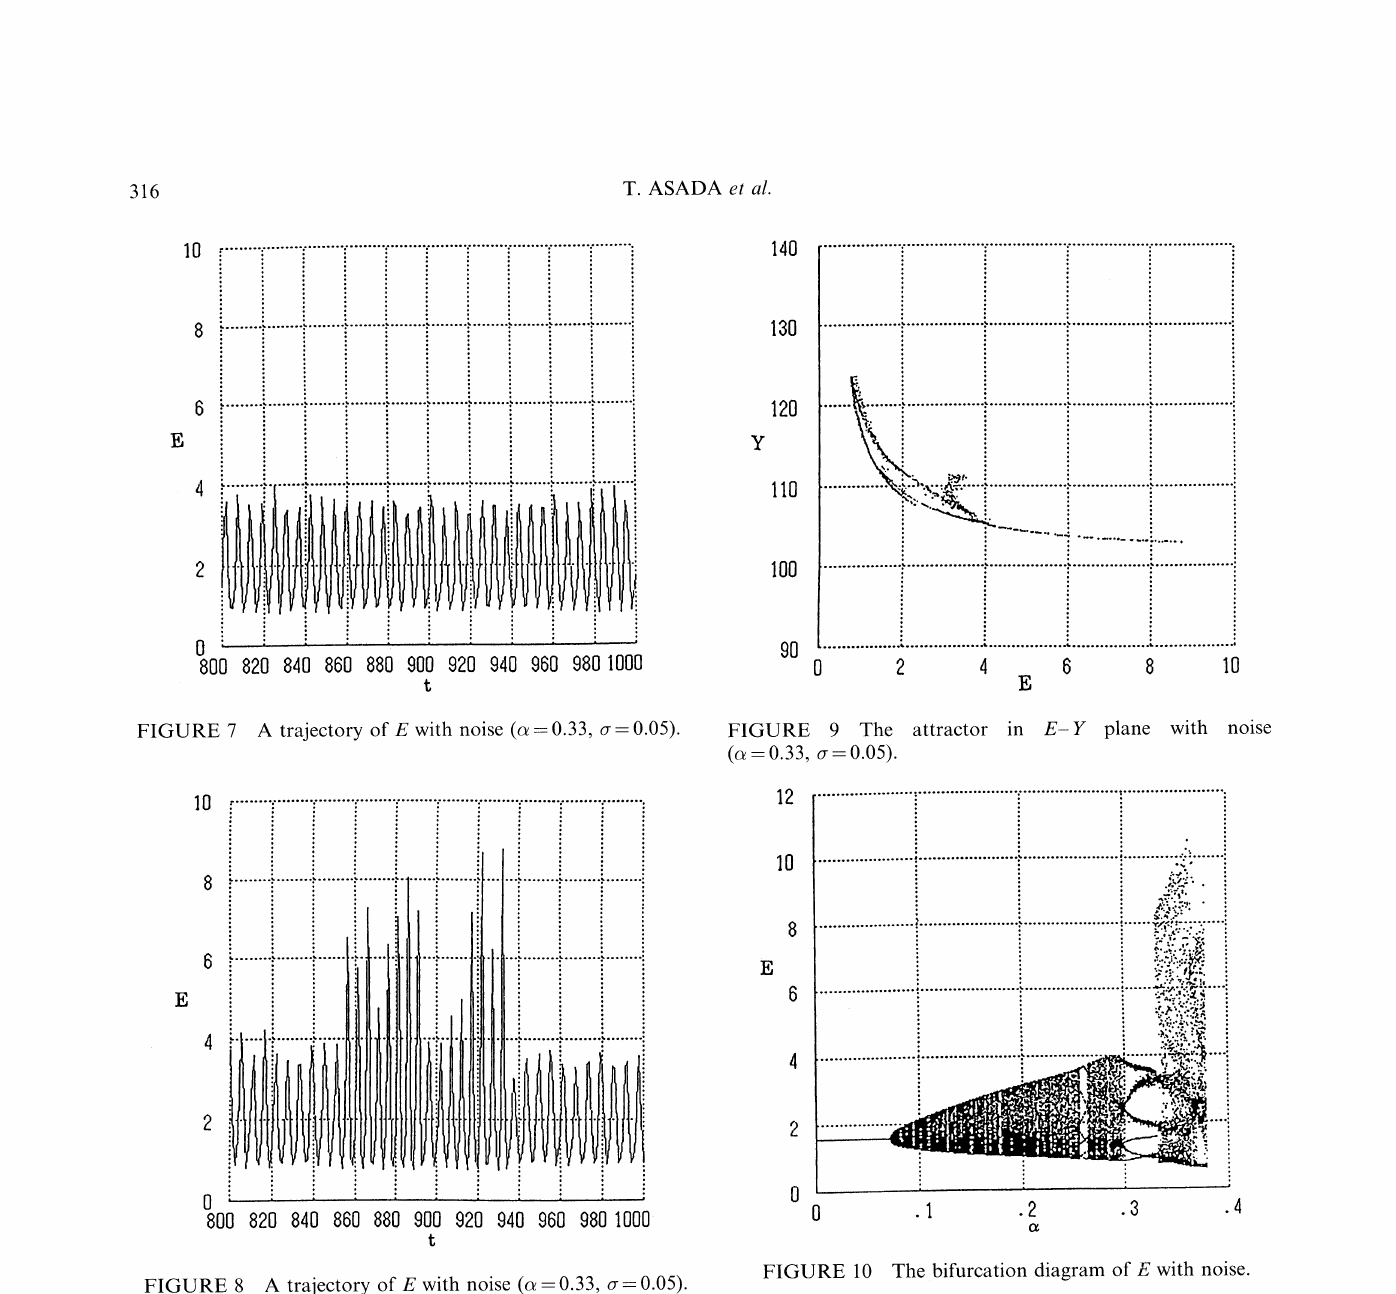
FIGURE 8 A trajectory of E with noise (c =0.33, a 0.05).